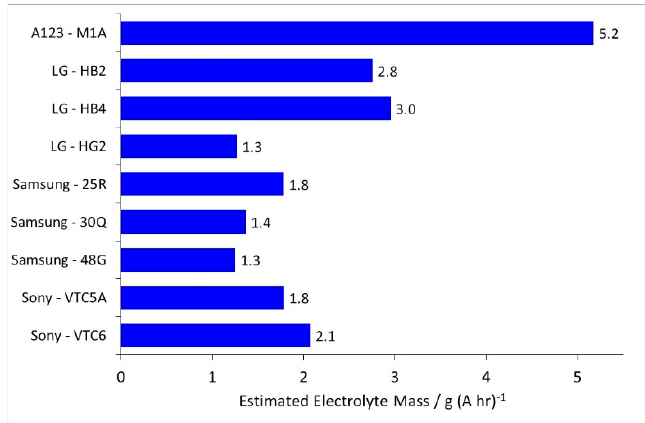
Figure 7. Estimated quantity of electrolyte used in cells.